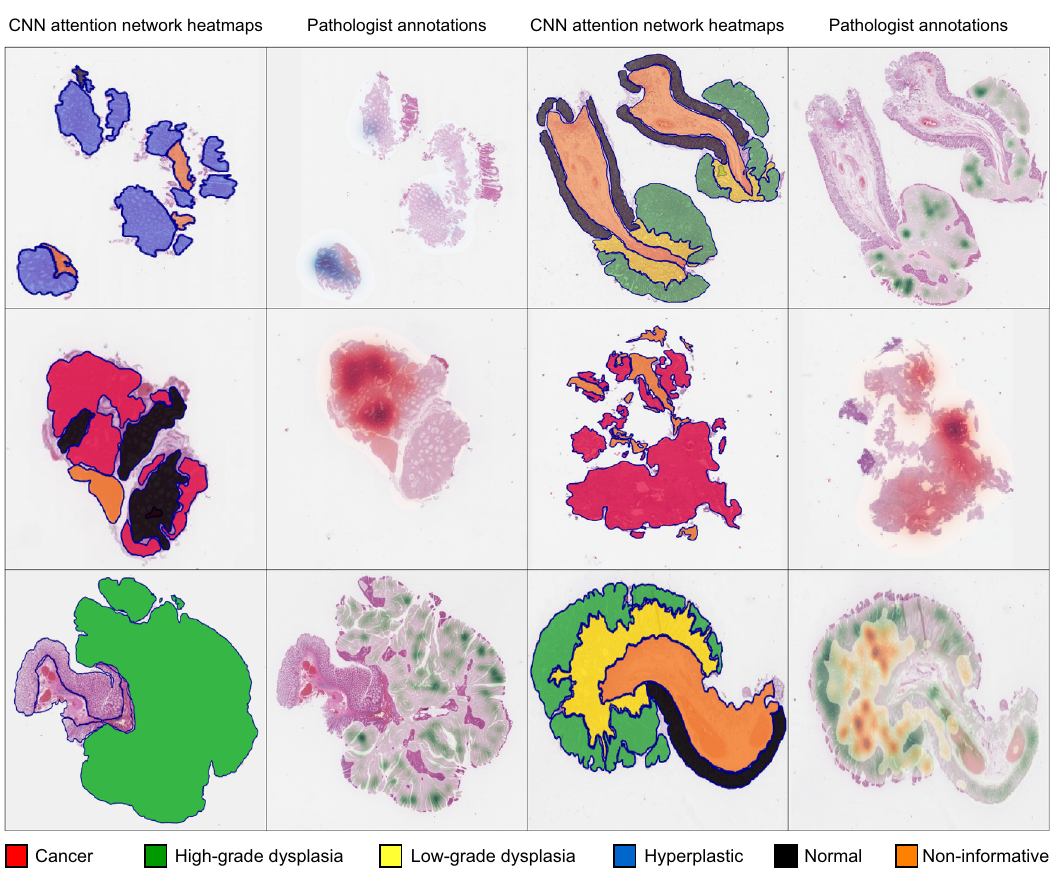
Fig. 4 Heatmaps. A few examples of heatmaps, generated with the attention network ’ s weights, compared with manual pixel-wise annotations made by pathologist. Each couple of examples includes a heatmap (on the left) and the corresponding pathologist pixel-wise annotations (on the right). The highlighted regions within the heatmaps represent the ones where model assigned the highest importance for the global diagnosis. The comparison of the heatmaps and the annotations shows that the attention network gives greater importance to regions including relevant